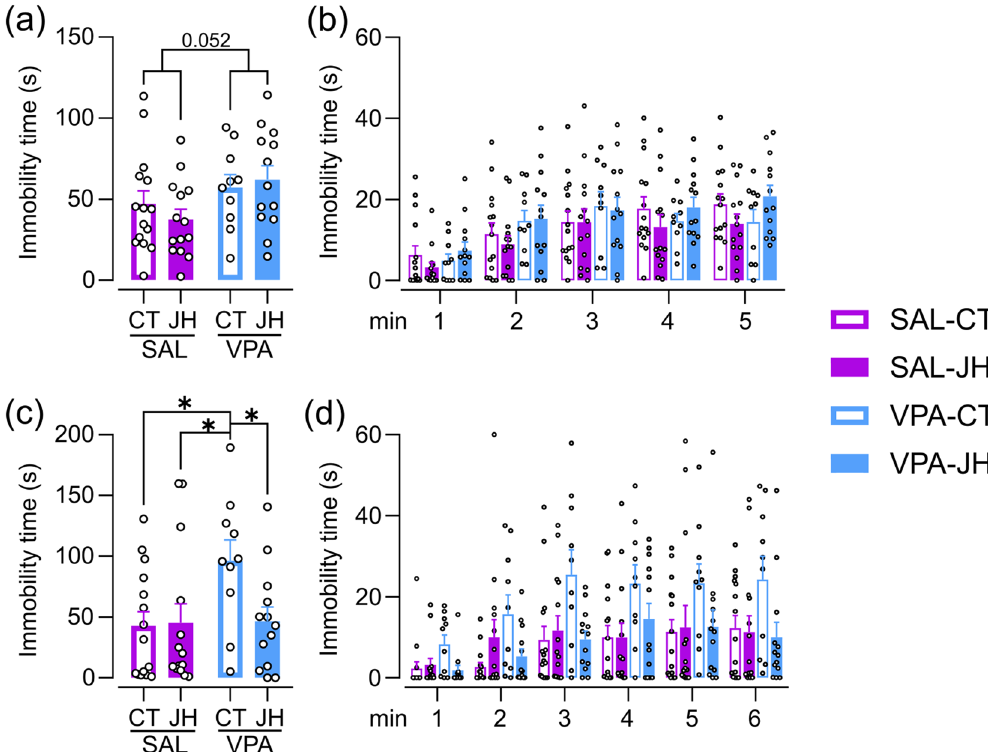
Figure 3. Effect of prenatal VPA exposure and JH on depression-related behaviors. ( a ) VPA-exposed animals showed a tendency to spend more time immobile during the tail suspension test in a LME model, ( b ) with no differences in any minute bin. ( c ) VPA-CT animals spent more time immobile than control and handled groups in the final 3–6 min period of the forced swim test. GLMM model followed by post hoc comparisons with FDR correction, *p < 0.05. ( d ) VPA-CT increased immobility is observed across all minute bins. Data are shown as individual values (dots) and mean + s.e.m. N SAL-CT = 15, N SAL-JH = 14, N VPA-CT = 10, N VPA-JH =